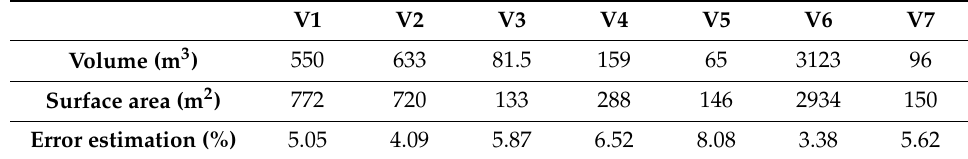
Table 2. Example of extracted material estimation in the analyzed time span.